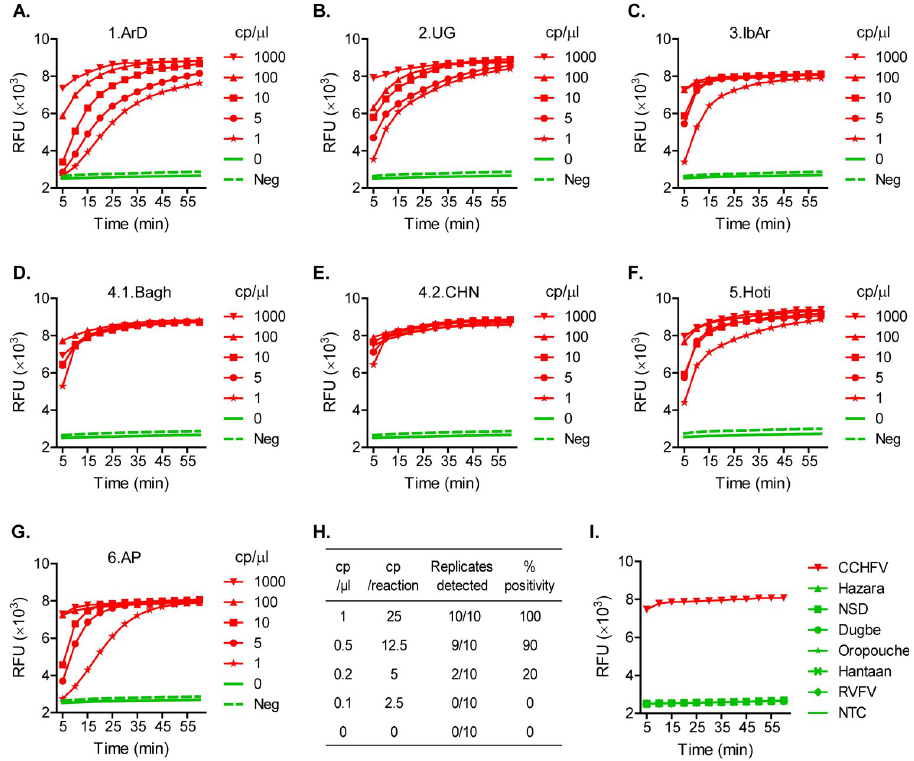
Fig 3. The degenerate sequence-based CRISPR diagnostic detects CCHFV in a sensitive, specific and rapid manner. A–G. Detection of all CCHFV clades/sub-clades. The S segment genomic RNAs representing different CCHFV clades/sub-clades were produced by in vitro transcription, serially diluted and tested for detection by the degenerate CRISPR set (CRISPR set 2). Amplification plots show relative fluorescent units (RFU) at indicated time points in the T7-Cas13a reaction. RNA template concentrations in the T7-Cas13a reaction are shown as copies/ μ l (cp/ μ l). Red curves: CCHFV RNA-containing samples; green solid curve (0 cp/ μ l): NTC (no-template control, H2O); and green dash curve (Neg): the negative threshold = Mean + 3X standard deviation of NTCs, calculated based on 12 NTC replicates. Any RFU value above the negative threshold is considered CCHFV positive. Graphs represent three independent experiments showing similar patterns. H. Limit of detection (LoD). The S segment genomic RNA from the Hoti strain was produced by in vitro transcription and tested at the indicated concentrations for detection by the degenerate CRISPR set. Positivity% values are shown based on 10 replicates per target concentration type. I. The degenerate sequence-based CRISPR diagnostic is specific for CCHFV, with no cross-reactivity against closely related viruses. RNAs from CCHFV and related viruses were tested for detection by the degenerate CRISPR set. NSD: Nairobi sheep disease virus; RVFV: Rift Valley fever virus; and NTC: no-template control (H2O). CCHFV and Rift Valley fever virus RNAs were extracted from cell culture-derived viruses. Other viral RNAs were the S segment genomic RNAs produced by in vitro transcription. RNA template concentrations in the T7-Cas13a reaction were all 40 pg/ μ l. Amplification plots show relative fluorescent units (RFU) at indicated time points in the T7-Cas13a reaction and represent three independent experiments showing similar